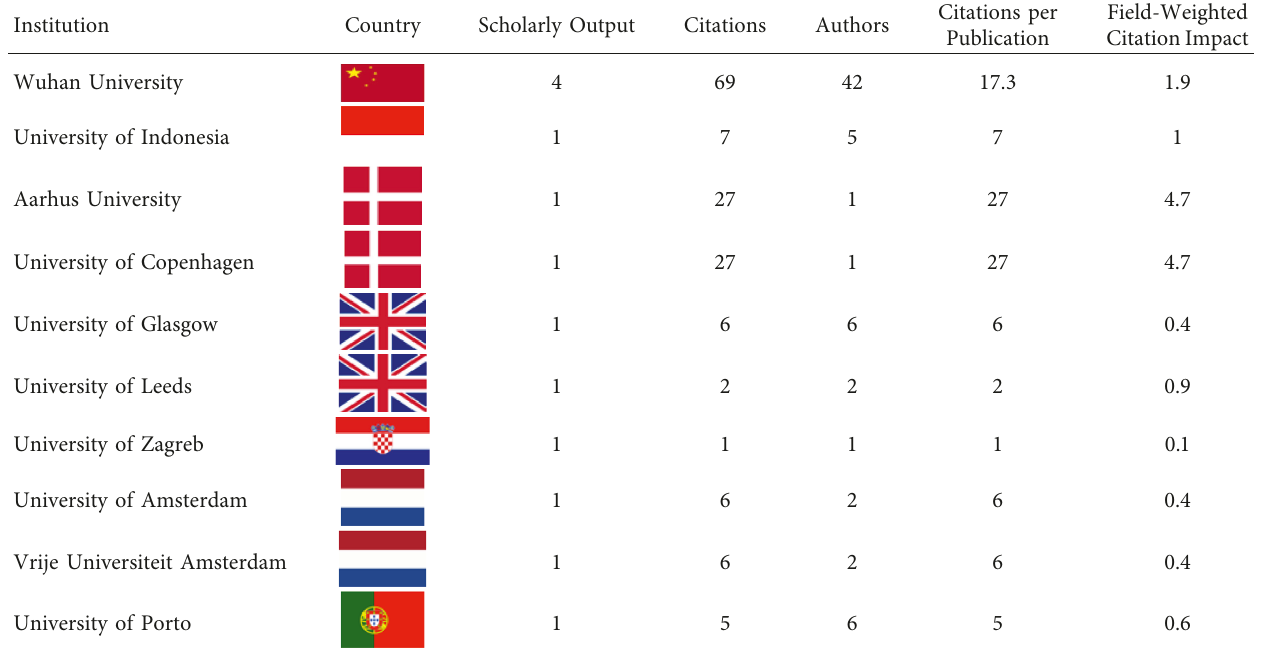
Table 1: Top 10 universities of scientific output in Scopus of all publication types about caries